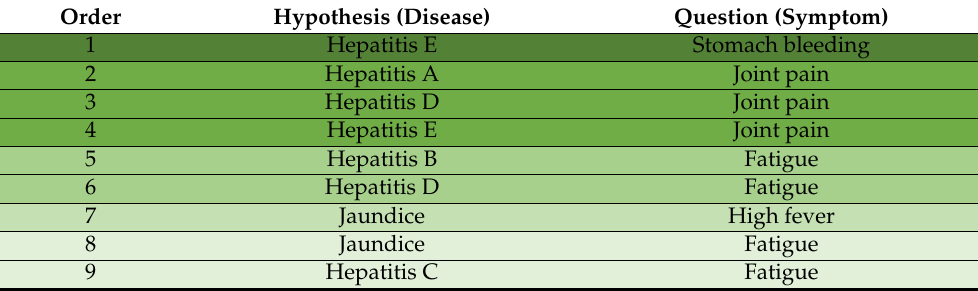
Table 4. The sorted list of hypotheses with their related questions returned by Algorithm